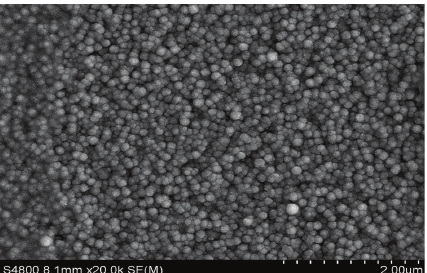
Figure 2: SEM Image of Cd 1 − x Zn x S thin films prepared by CBD.